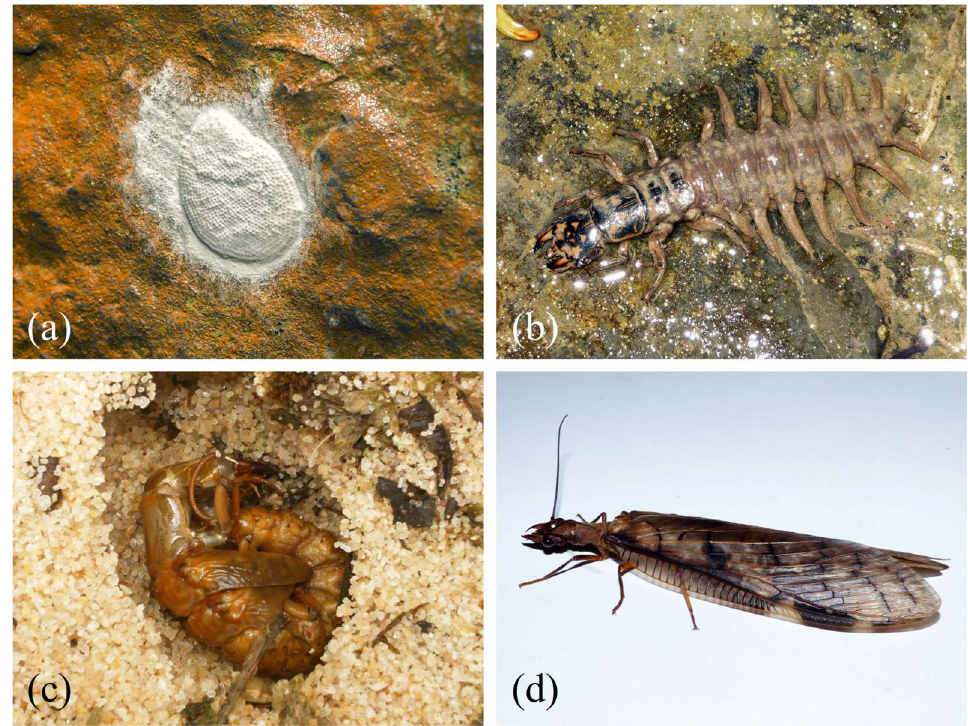
Figure 2. Developmental stages of Corydalus . ( a ) egg mass of Corydalus sp., ( b ) mature larva of Corydalus liui , ( c ) pupa of Corydalus peruvianus Davis, 1903, ( d ) female of Corydalus liui . Images by Adrian Ardila-Camacho.